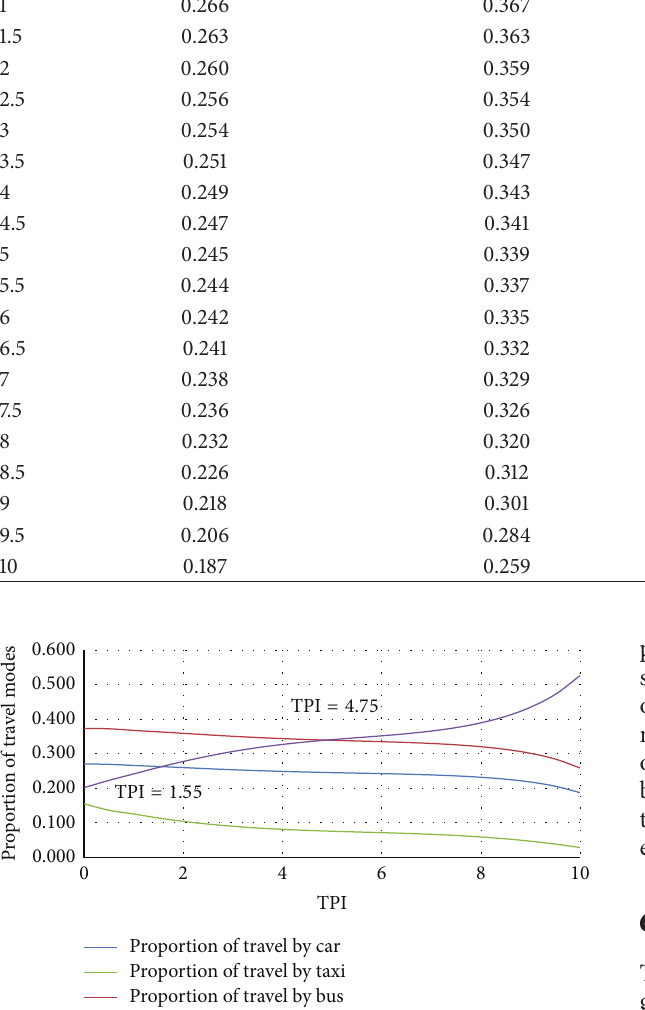
The proportion of inhabitants travelling by rail is a monotonically increasing function of TPI, the trend line of travel by rail intersects the line of by car at the point where the TPI equals 1.55, and it intersects the line of by bus at the point where the TPI equals 4.75. The proportion of travel by rail is less than travel by car when the value of the TPI is less than 1.55 and is greater than travel by bus when the TPI value is greater than 4.75. That is, in the unimpeded traffic state, the inhabitants generally tend to choose travel by bus or by car because of shorter walking time and more flexible